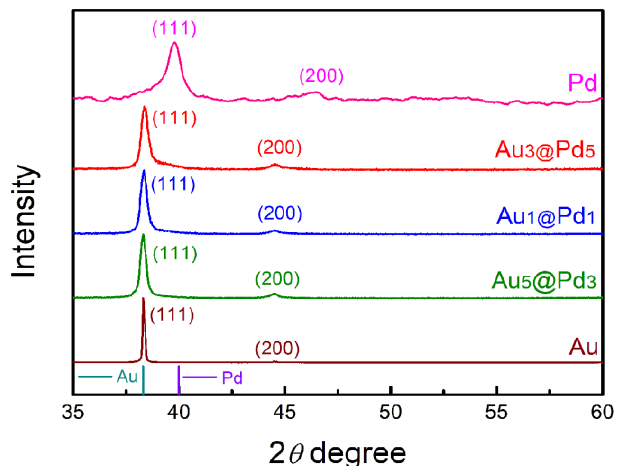
Figure 4. XRD data of Pd, Au3@Pd5, Au1@Pd1, Au3@Pd3 DNPs and Au NPs.